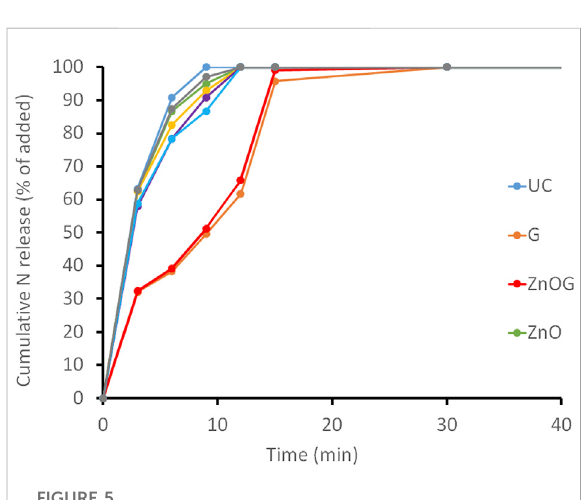
FIGURE 4 Crushing strength of fertilizer samples. Small letters over each bar indicate the difference among treatments at a 5% probability level. Error bars represent the standard error of the mean ( n = 3). Inset in the fi gure represent the result of the analysis of variance (ANOVA).